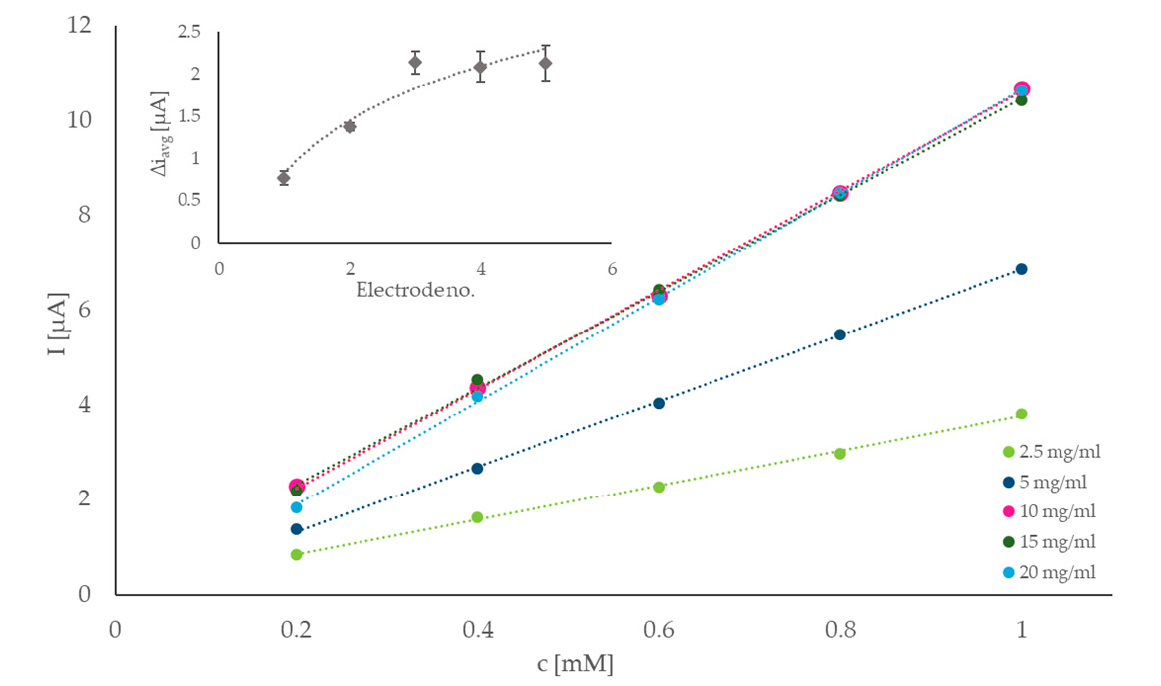
Figure 3. Optimization of GOX concentration on the electrode surface—the current response of electrodes with 2.5, 5.0, 10, 15, and 20 mg/mL GOX plotted against glucose concentration. Trendline slopes were used to determine the sensitivity of the electrodes. Insert: average current response of the same electrodes to repeated 0.2 mM additions of